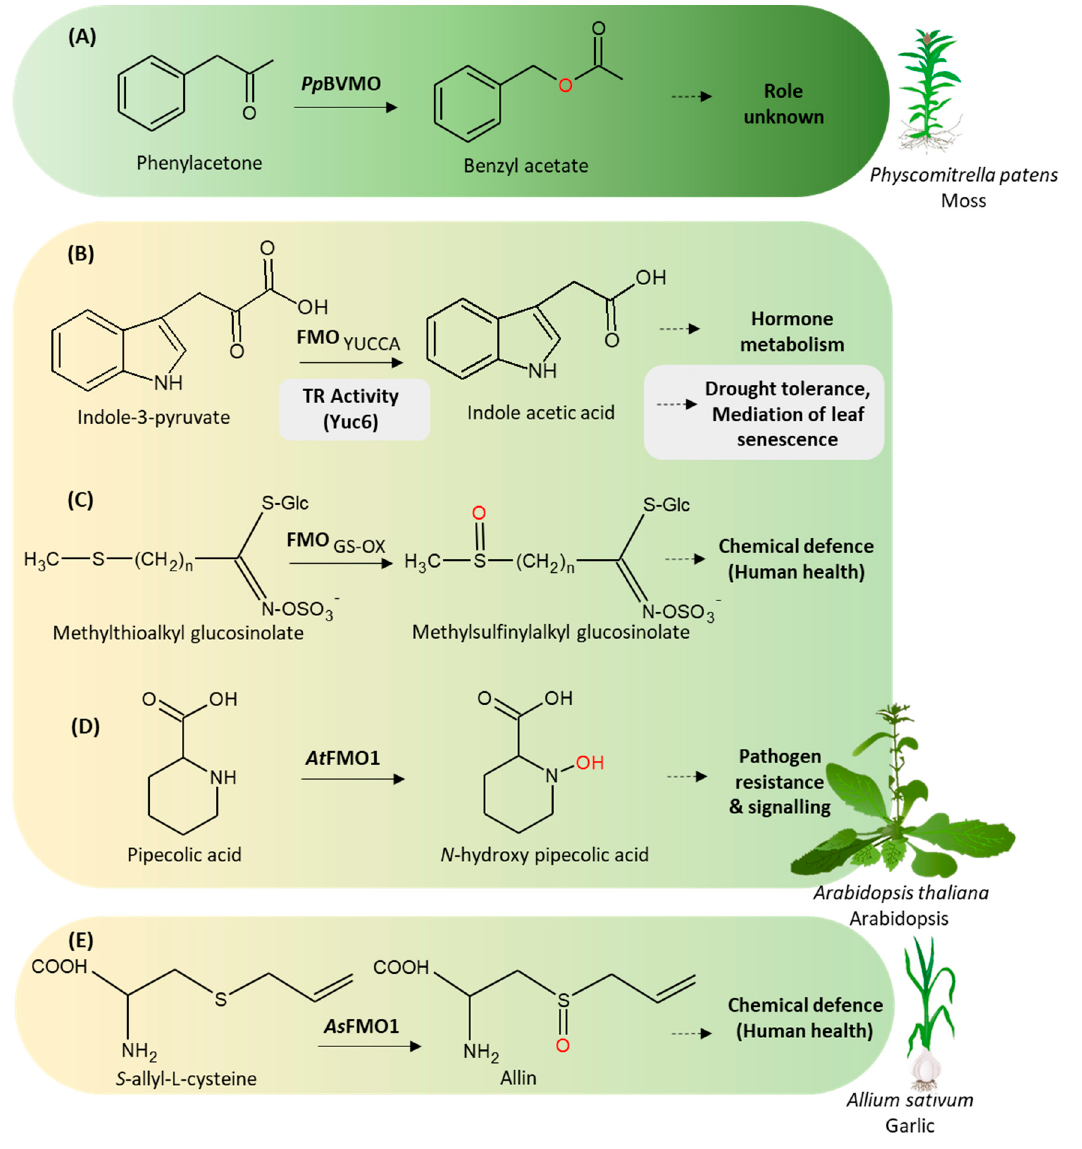
Figure 2. Representative plant FMO reactions and their physiological roles. ( A ) The Pp BVMO from Physcomytrella patens can perform a Baeyer-Villiger C–C cleavage and insertion of oxygen on phenylacetone to form benzylacetate in vitro (amongst other reactions). ( B – D ) Characterized FMO reactions from Arabidopsis thaliana include oxidative decarboxylation, S-hydroxylation, and N-hydroxylation. ( E ) The characterized As FMO1 from garlic ( Allium sativum) performs an S-oxygenation. Insert: ArabidopsisYuc6 from also possesses thiol-reductase (TR) activity that is independent of auxin biosynthesis. See text for references.